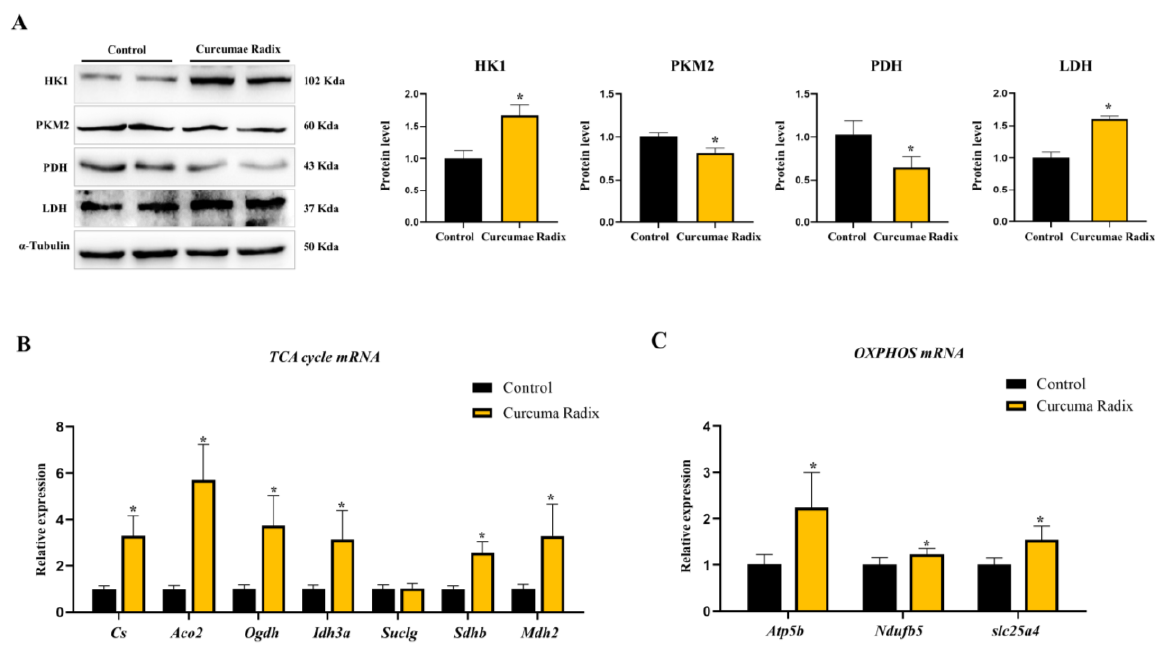
Figure 3. Curcumae radix regulates glycolysis and increases the Tricarboxylic acid (TCA) cycle, Oxidative phosphorylation (OXPHOS). ( A ) Western blot analysis and quantification of glycolysis related genes were evaluated in the cerebrum of CRE treated male mice. Alpha-Tubulin was used as an internal control. ( B ) TCA cycle genes mRNA levels were measured by quantitative RT-PCR in the cerebrum of CRE-treated male mice. RPLP0 was used as an internal control. ( C ) OXPHOS mRNA levels were measured by quantitative RT-PCR in the cerebrum of CRE-treated male mice. RPLP0 was used as an internal control. The values stand for means ± S.D. * p < 0.05 was compared to the groups indicated. All experiments were repeated at least 3 times.